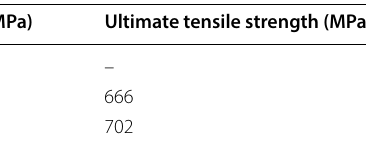
Table 2 Mechanical property of the concrete, stirrup steel bar and steel wire